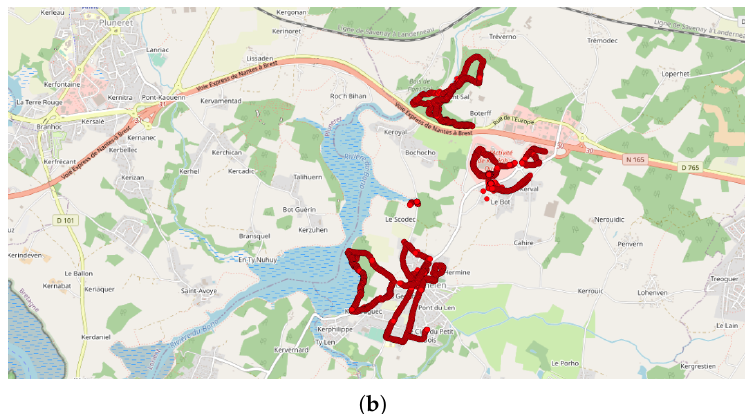
Figure 5. Representation of the clustering results for the NC party Id N°13 in the “Morbihan” department in France (lines 18 and 19 of Table 2). It compares the two options “Off” and “On” for the “Accuracy” filter. Only one cluster is found: red points correspond to the points of the cluster (NC party + Extra points); black points correspond to the points of the NC party that are not clustered (5 “isolated” black points: 4 on the left and 1 on the right of Figure 5a); represented area of approximately 3.4 km × 5.6 km; ( a ) “Accuracy” = “Off”; ( b ) “Accuracy” =